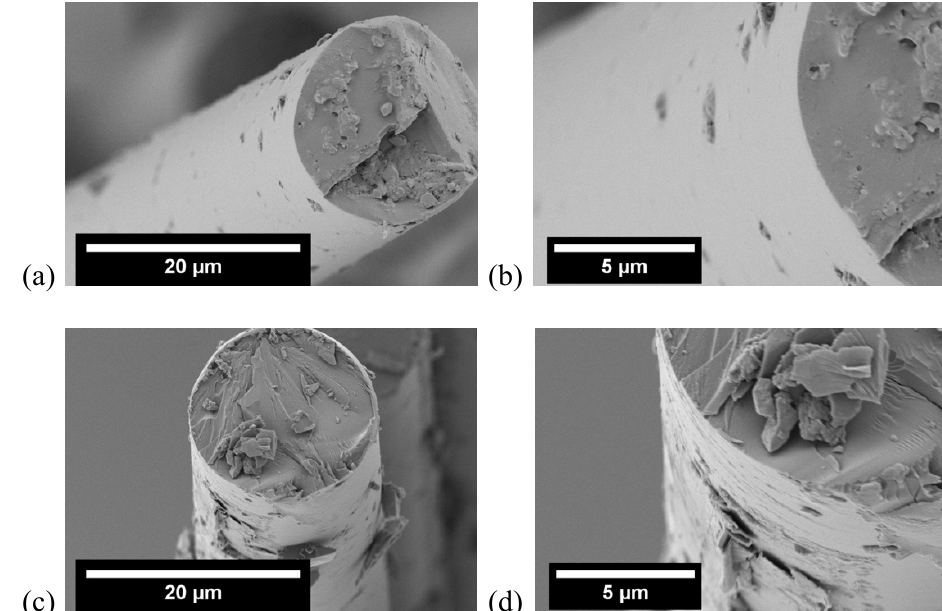
Figure 3. Scanning electron microscopy of cross-sectional view of neat GF ( a and b ) and GF-coated by rGO ( c and d ) under 2A processing condition.